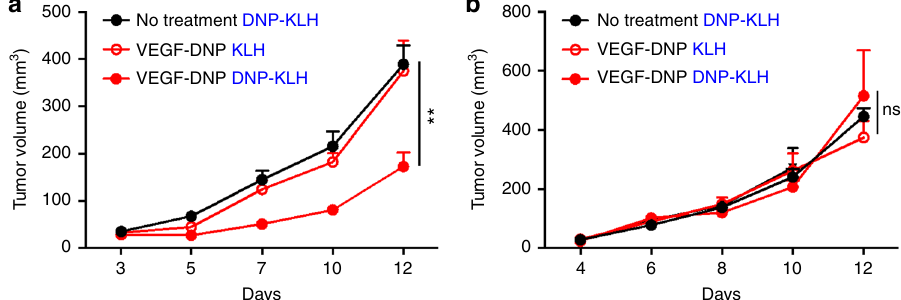
Fig. 4 FcR expression dependence of VEGF – DNP-mediated tumor inhibition in DNP immune mice. Wild type ( a ) and FcR-de fi cient ( b ) C57BL/6 mice were immunized against DNP (DNP-KLH) or mock immunized (KLH), challenged subcutaneously with MC38 tumors and 4 – 5 days later when tumors became palpable mice were treated with VEGF – DNP conjugate and tumor growth was measured. Statistical analysis ( a ), VEGF – DNP in DNP-KLH versus KLH vaccinated mice, ** p = 0.0025, student ’ s t -test (7 mice per group) ( n = 1); ns not signi fi cant ( p > 0.05). Data are represented as mean ±